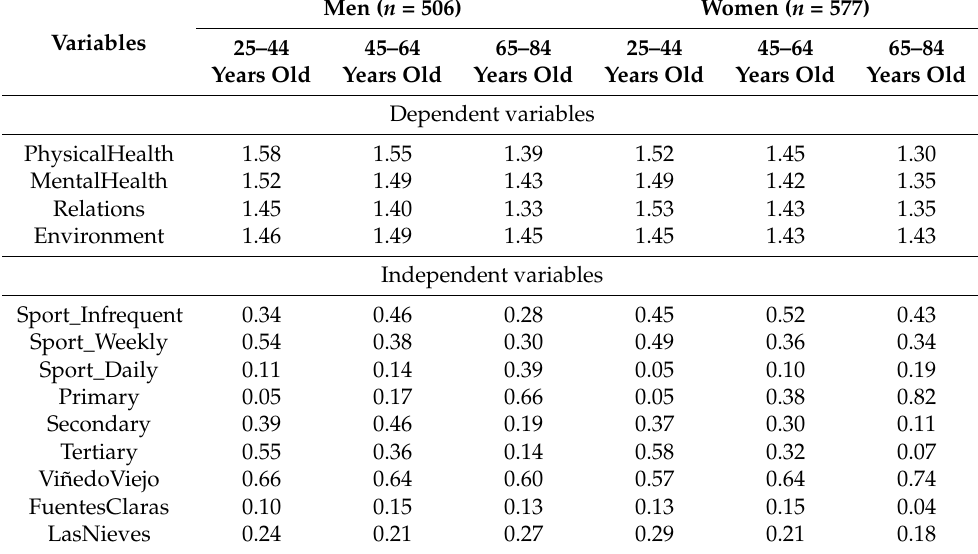
Table 3. Mean of the dependent and explanatory variables by sex and age ( n = 1083). Men ( n = Variables